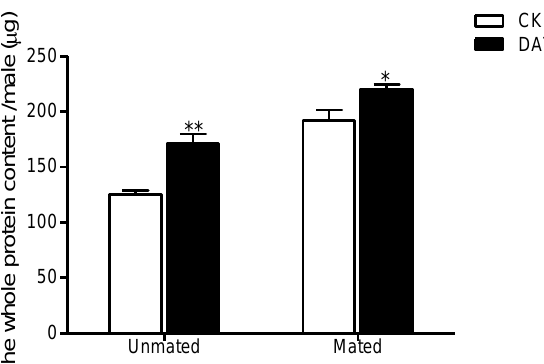
Figure 1. The whole protein content of males was determined in the control (CK) group (at 19 h after emergence) and diallyl trisulfide (DAT) group (treated with 0.01% diallyl trisulfide for 7 h at 12 h after emergence) both before and after mating. The data in the figure are presented as the mean ± SEM. Asterisks depict significant differences relative to the control treatment (*, p < 0.05; **, p < 0.01).